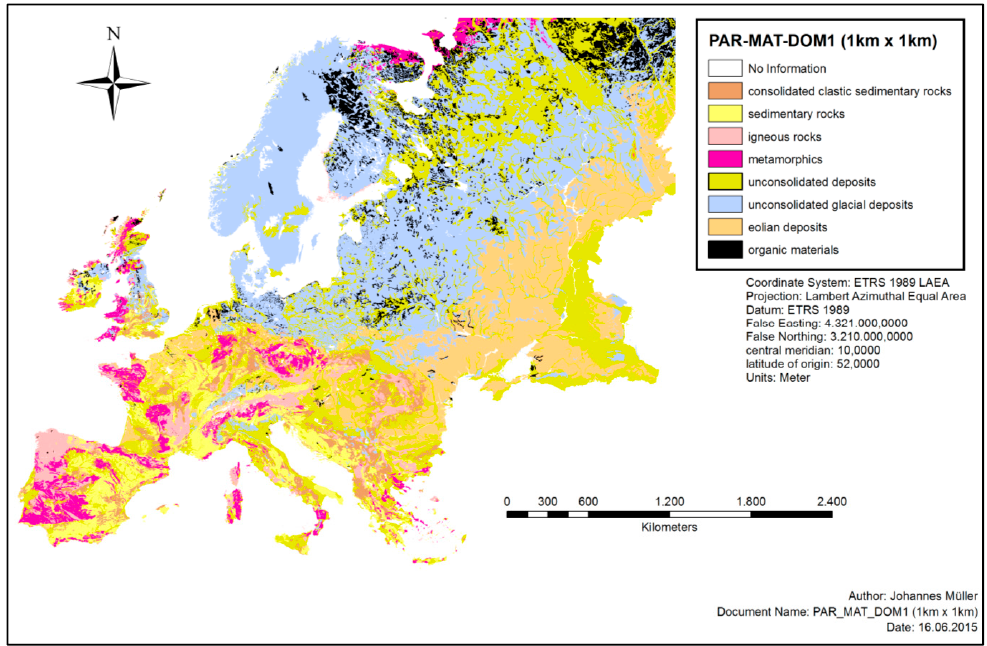
Figure 3. Major groups for dominant, parent material using attributes of PAR-MAT-DOM1, modified after van Liedekerke et al. [12].